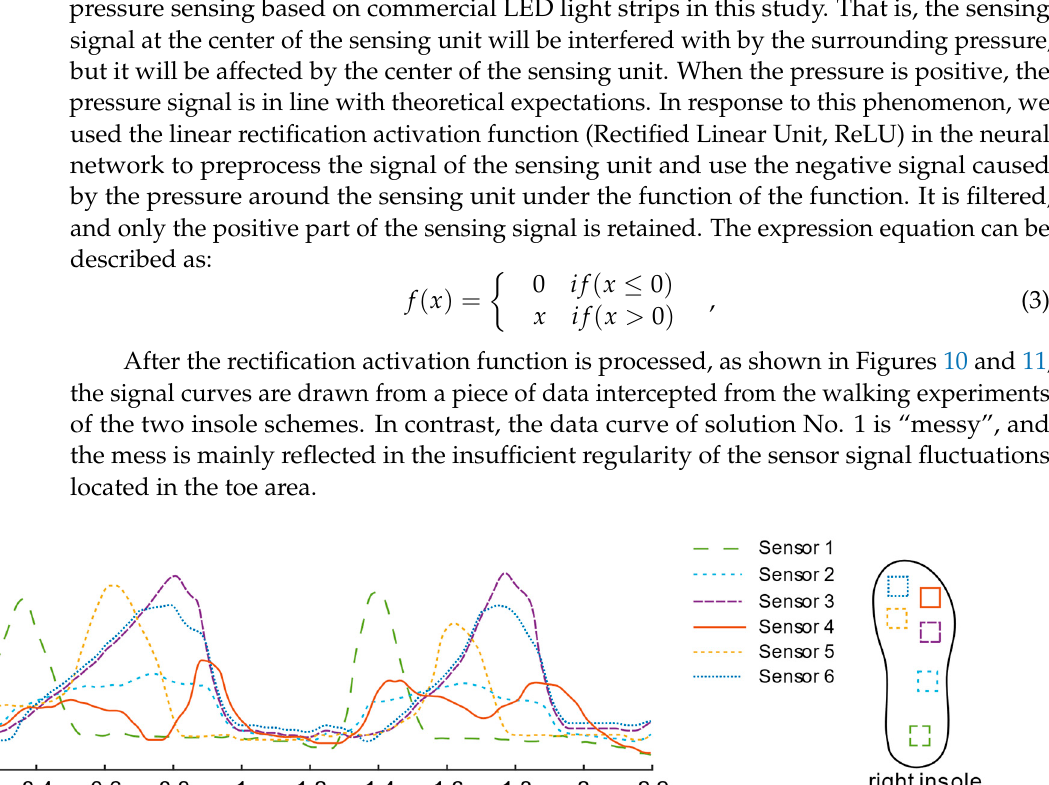
Figure 11. Signal Curve of the second insole solution.